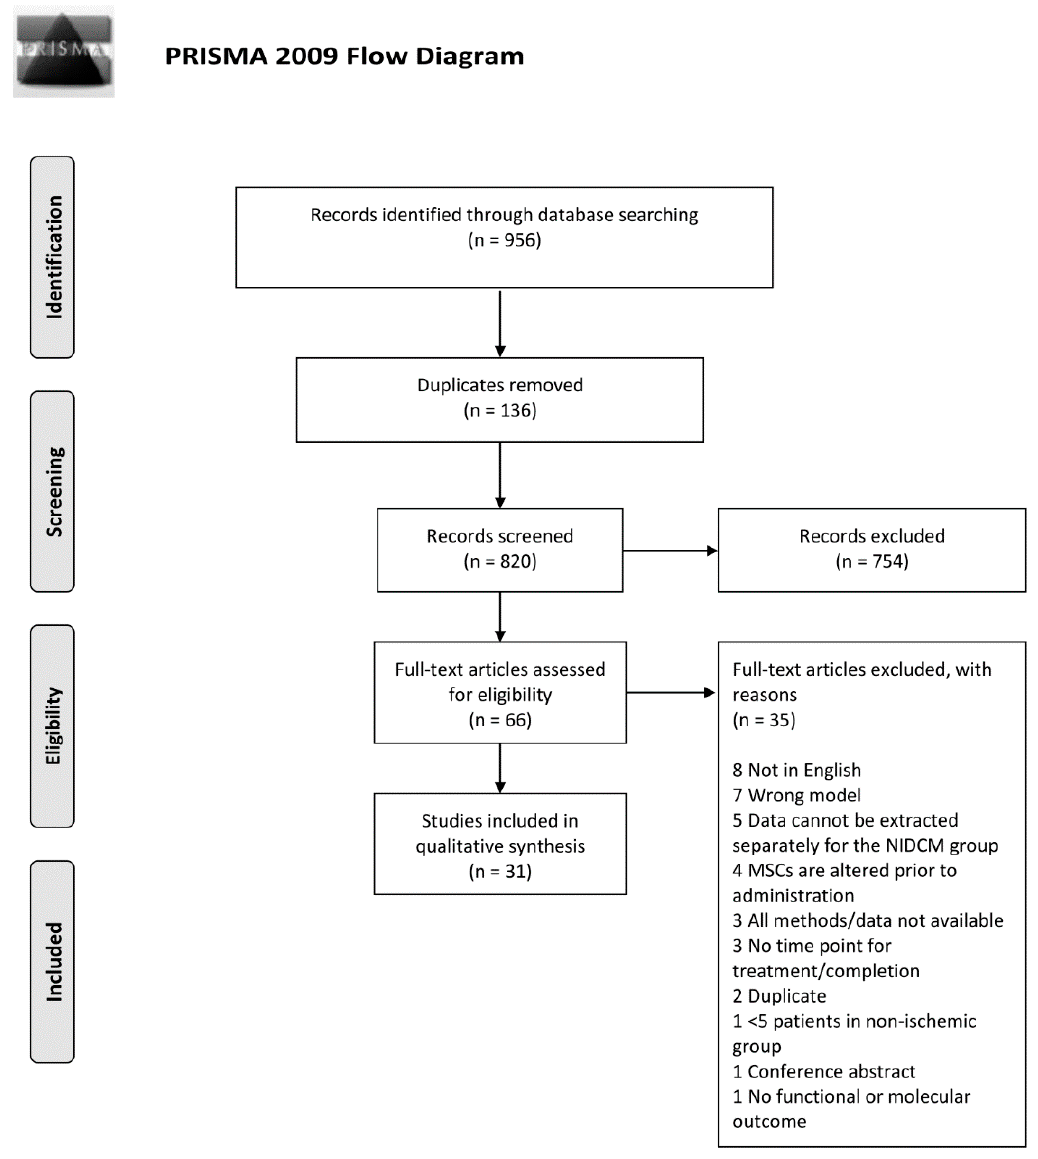
Figure 1. PRISMA flow chart illustrating the inclusion process of literature. PubMed and Embase were used for identification of existing literature.